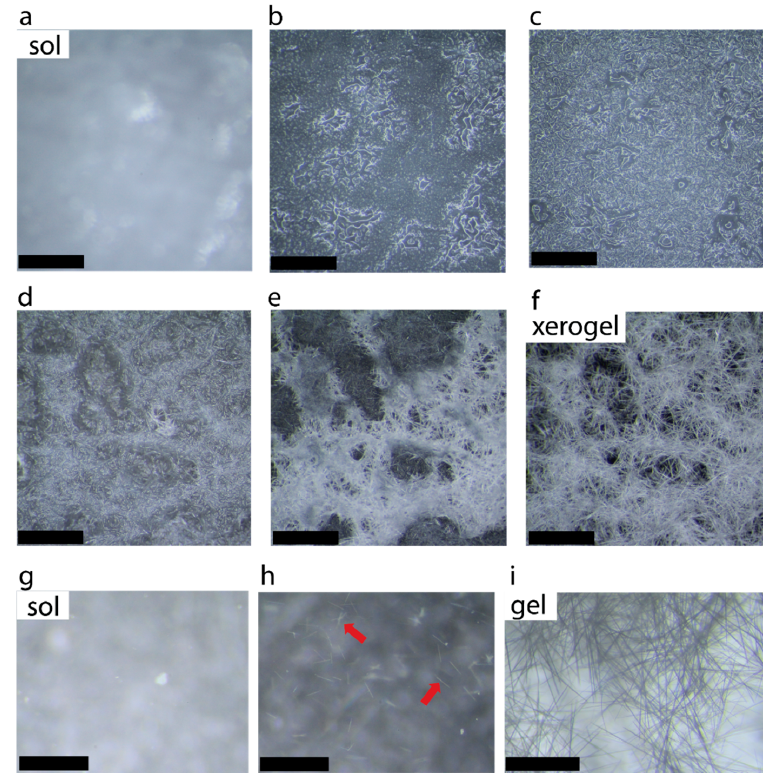
Figure 2. Photographs of 2.0% caffeine in 1-propanol ( a – f ) when a hot solution was placed on a glass slide (scale bar 0.85 mm) and ( g – i ) selected images of 2-0% caffeine in 1-propanol hot solution placed in a petri dish showing fiber formation in the presence of solvent (scale bar: 0.92 mm). Red arrows indicate the formatin of microcrystals.